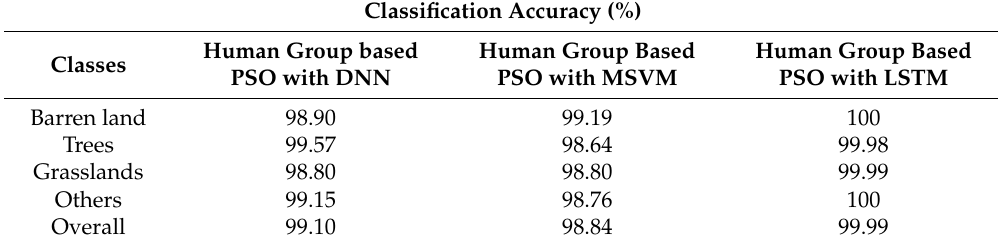
Table 5. Performance investigation of the proposed model with different classifiers on Sat 4 dataset by means of accuracy.